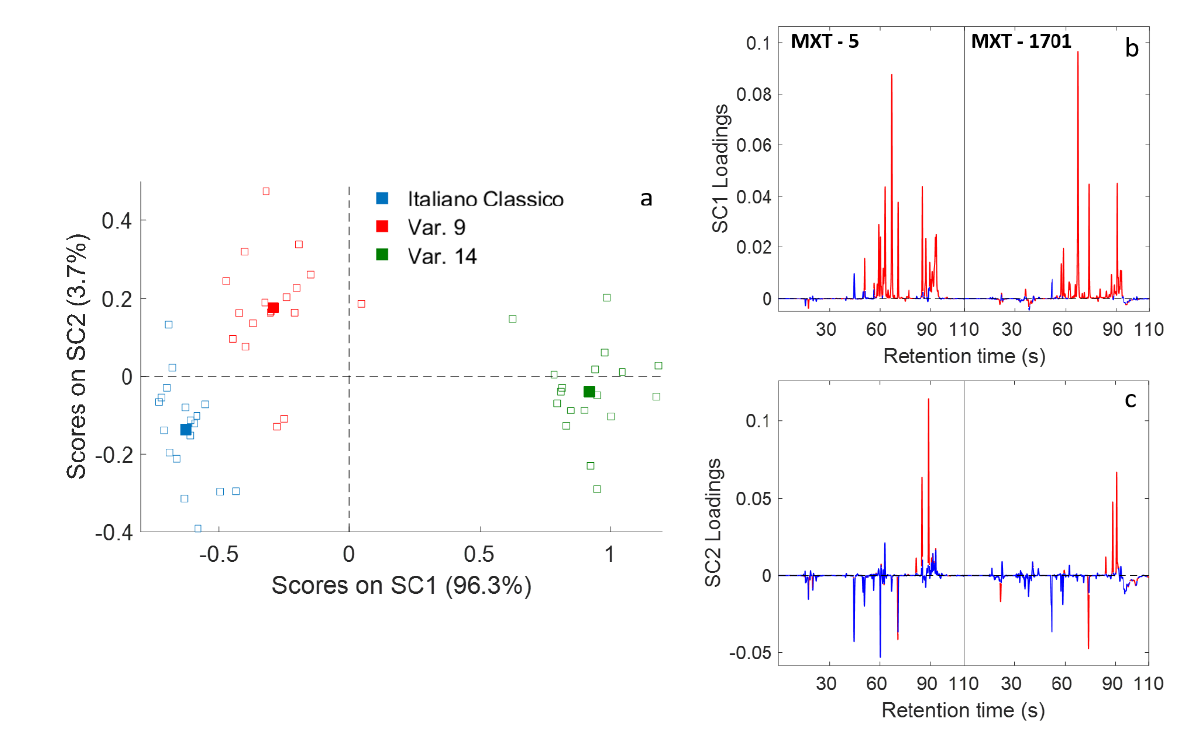
Figure 5. SCA for the effect of the factor “variety”. ( a ) SC1 vs. SC2 score plot. Empty symbols represent the projected residuals; ( b ) SC1 and ( c ) SC2 loadings plot. In the loading plots, red lines indicate statistically significant regions, whereas blue lines indicate regions associated with loadings statistically indistinguishable from zero.